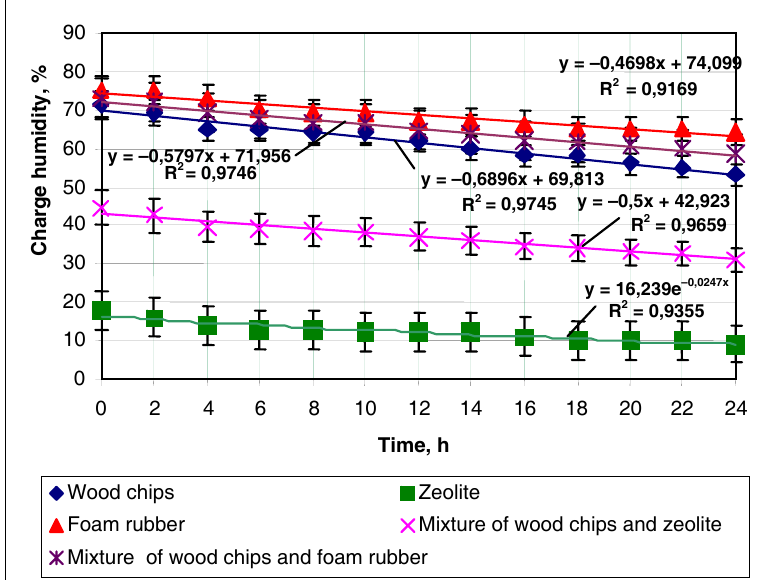
Fig 5. Dependence of the charge humidity on time